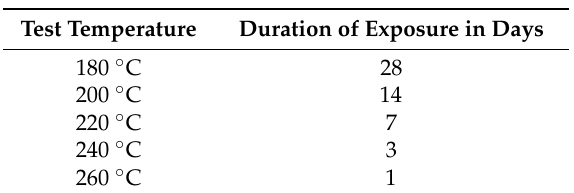
Table 3. The test coils are separated into groups which will be submitted to several aging temperatures for a specified time (IEC-60216).